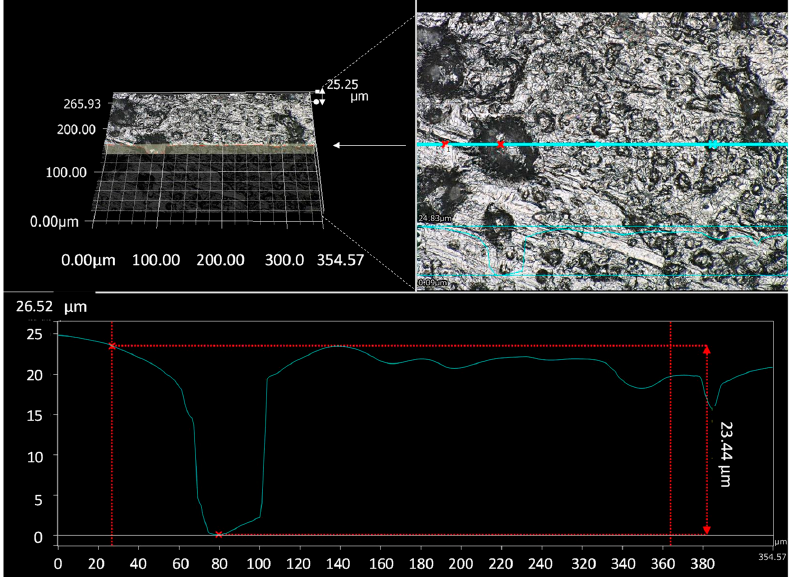
Figure 7. Roughness observed by optical microscope; ( upper left ) bird’s-eye view, ( upper right ) enlarged image, ( under ) roughness of the cross section.